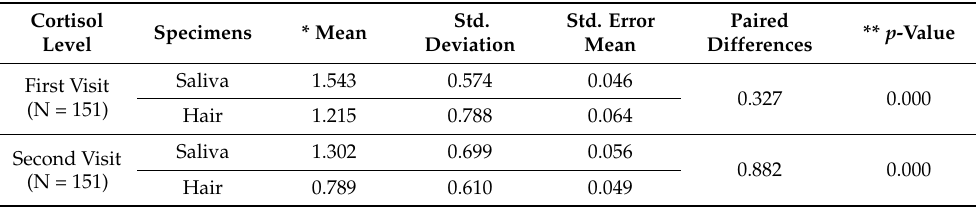
Table 3. Comparison of cortisol levels in saliva and hair specimens of the participating students (N-151).